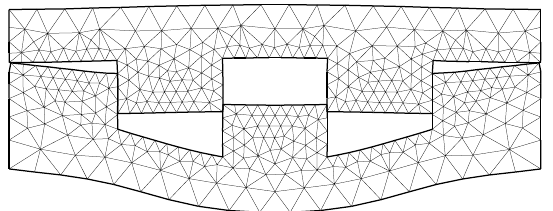
Figure 6.13 . Deformed configuration of the two elastic bodies.